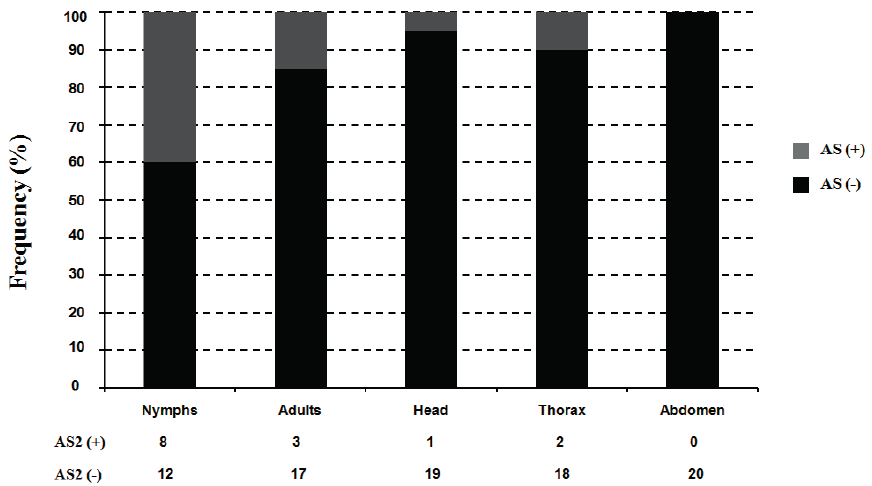
Figure 6. The relative frequencies of the TciRyR optional exon (AS) in nymph, adult, adult head, adult thorax, and adult abdomen. The number of clones containing each alternative splice variant amplified by semi-qRT PCR is listed